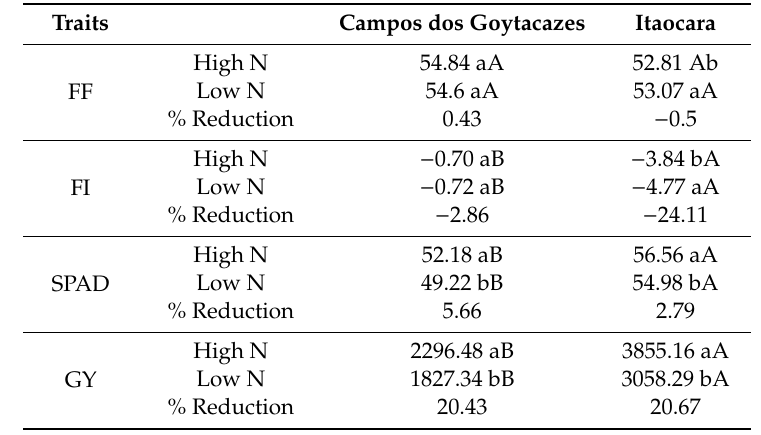
Table 4. Means and percentage of reduction between the nitrogen levels of the variables: female flowering (FF) in days, male to female flowering interval (FI) in days, chlorophyll content (SPAD), and grain yield (GY) in kg ha − 1 , evaluated in 90 popcorn